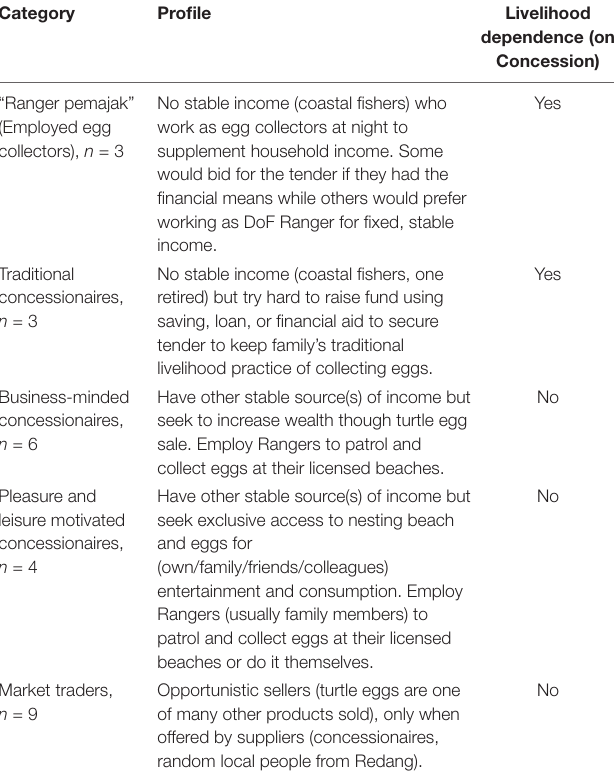
TABLE 2 | Categories of concession participants based on their profile and livelihood dependence. Category Profile Livelihood